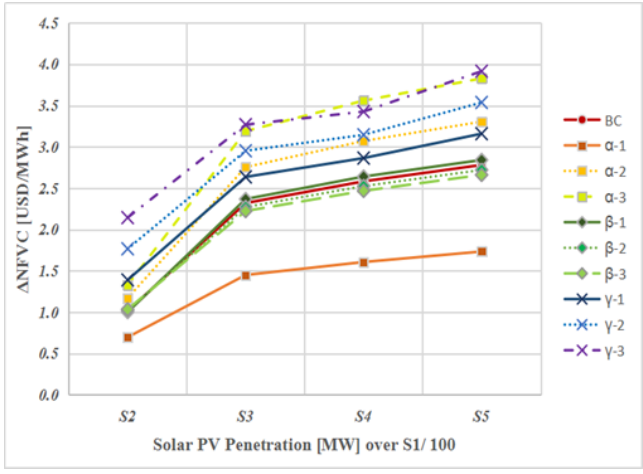
Figure 7. ΔNFVC Rate of the units from natural gas cluster for different scenarios and cases. Figure 7. ∆ NFVC Rate of the units from natural gas cluster for different scenarios and